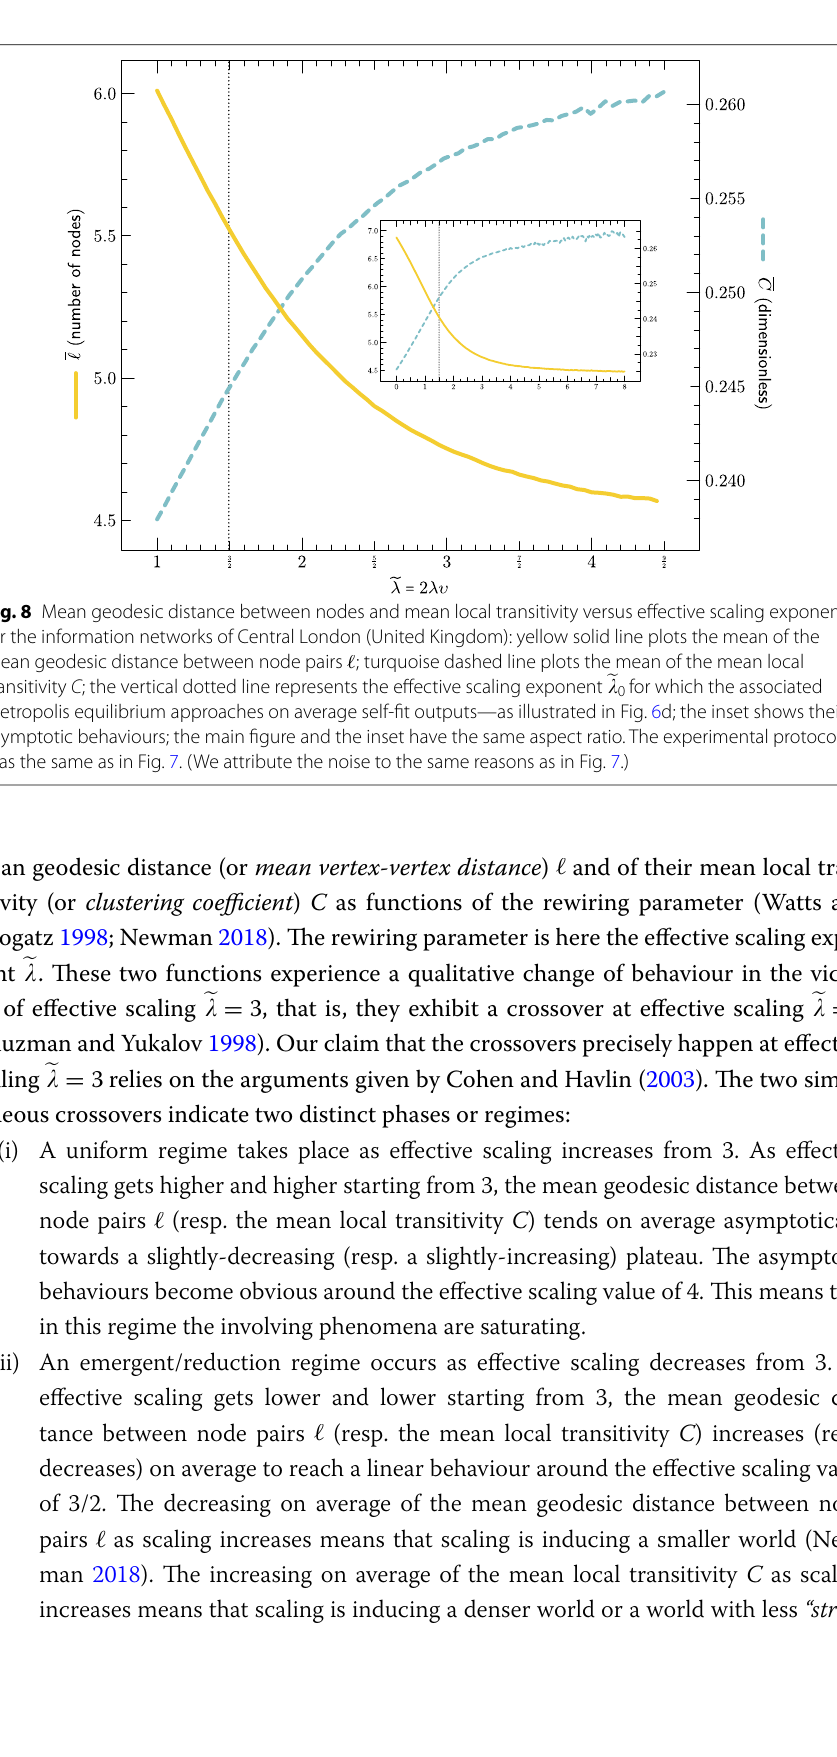
(cid:31) 0 for which the associated (cid:31)